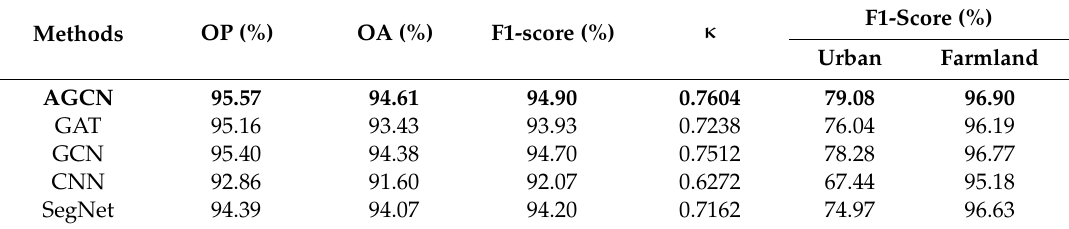
Table 7. Comparison of di ff erent segmentation methods on the Pucheng dataset.